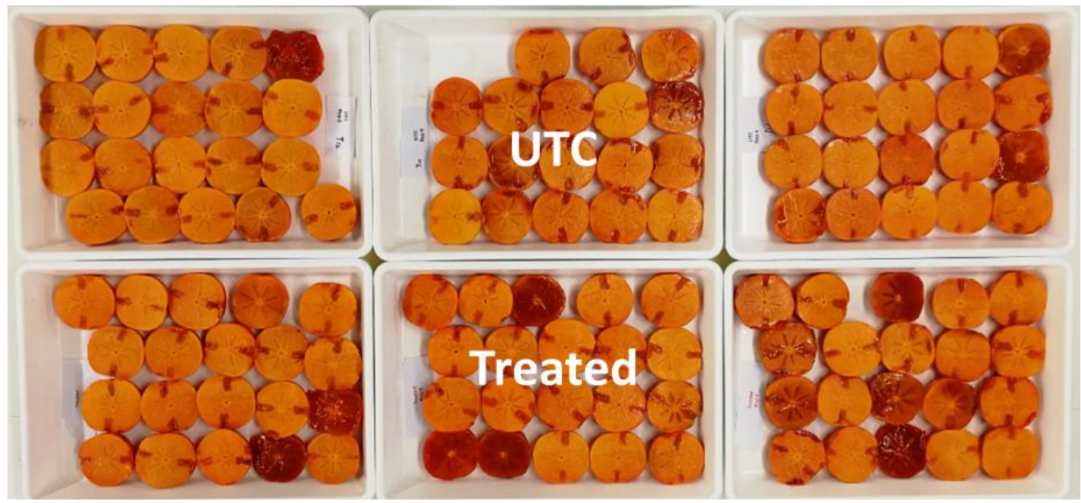
Figure 6. Untreated control ( top ) and treated ( lower ) ‘Jiro’ persimmon fruit cut in half (after firmness measurement = hole / darkened in the side of the fruit) after three weeks storage at 15 ◦ C. Darker fruit are fruit with full internal gelling